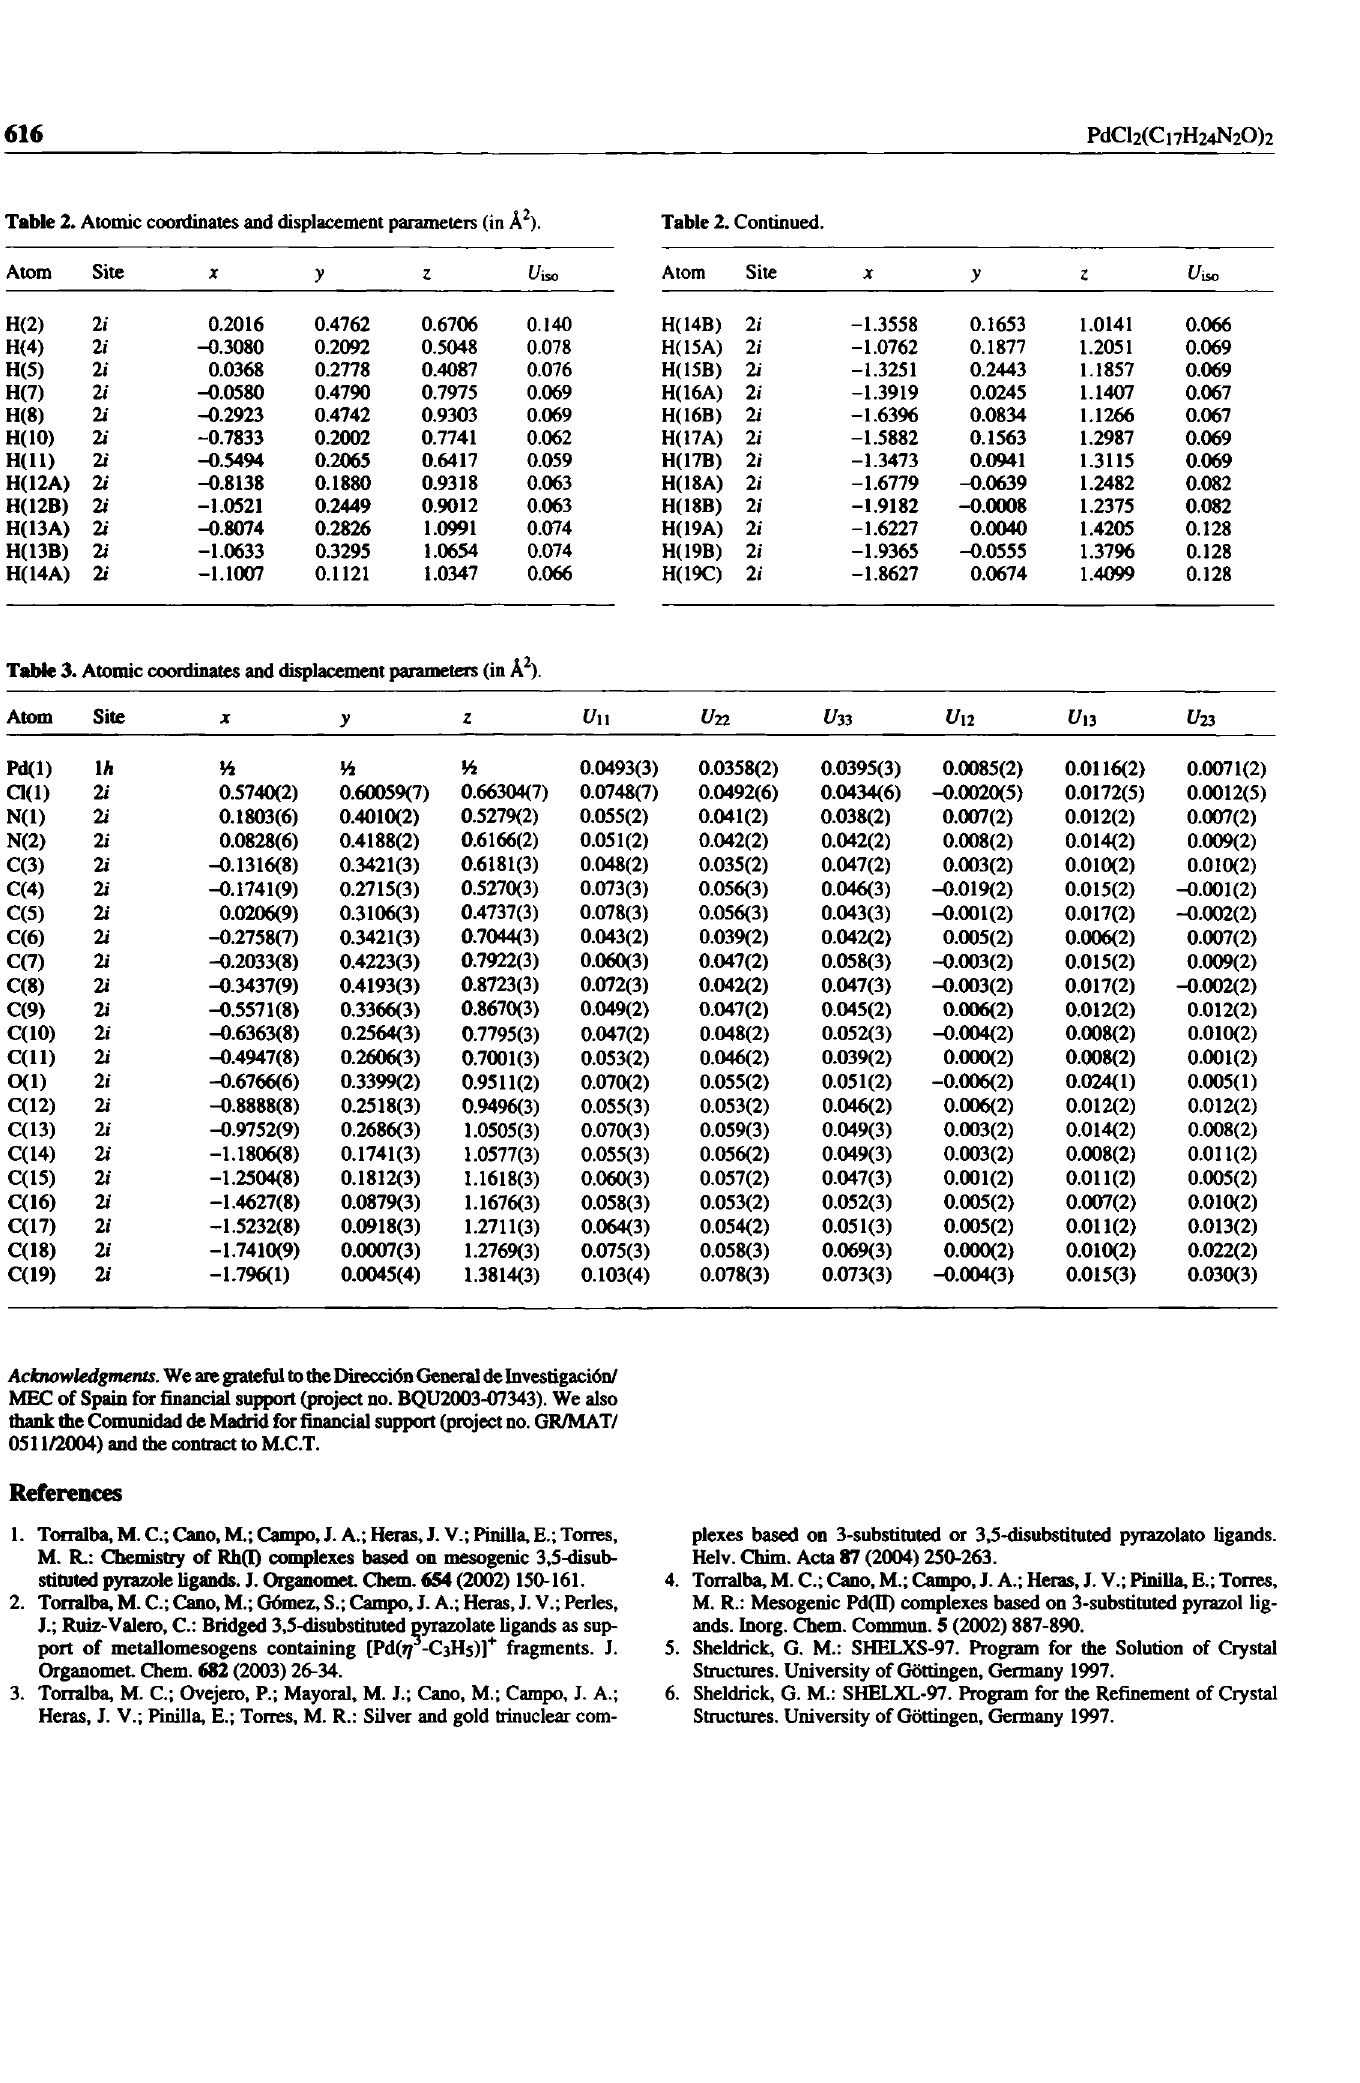
Table 3. Atomic coordinates and displacement parameters (in Ä 2